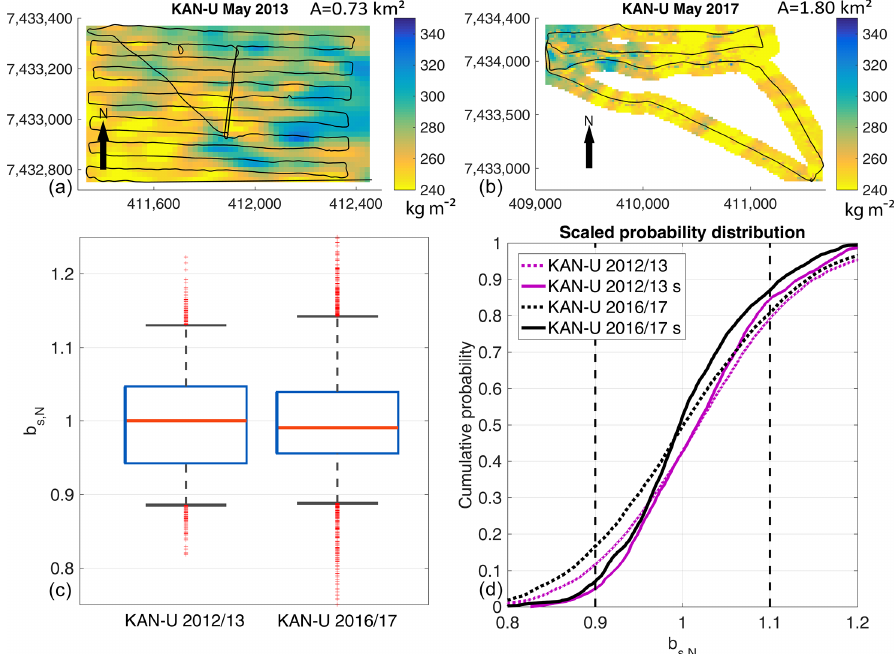
Figure 7. (a, b) Kriging results for the radar transect at KAN-U for snow accumulation. The black lines show the recorded radar traces, and the black arrows indicate geographic north. The letter A is the total area covered by extrapolation. (c) Box plots displaying normalized data distribution ( b s , N ) of kriged outputs with the red horizontal line showing the median, the blue box framing the interquartile range, and the whiskers displaying the 5th and 95th percentiles. Outliers are shown as red crosses. (d) Normalized cumulative probability distribution of radar-derived b s within any subset with a 1m radius (3m radius for 2012/2013) of the GPR transects. The dashed vertical lines represent the determined error margins of ± 10%. Compared are filtered (solid lines and letter s) with unfiltered (dotted lines) radar transects. All map coordinates are given in UTM zone 23N with datum WGS